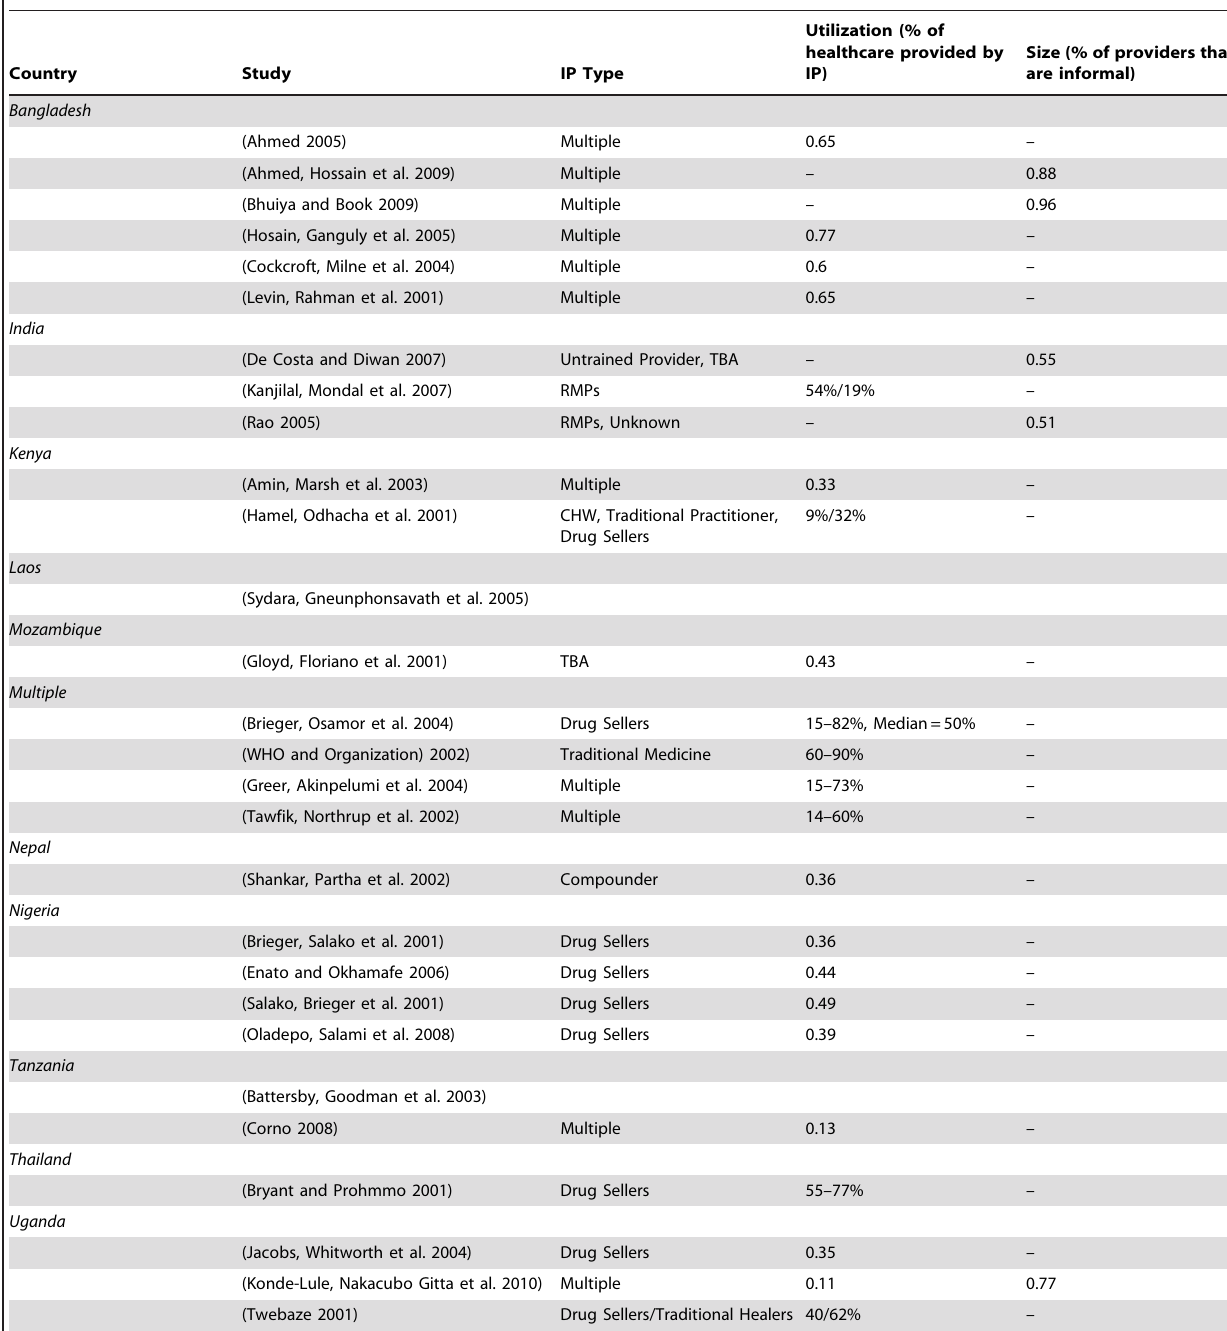
Table 2. Size and Utilization of the Informal Healthcare